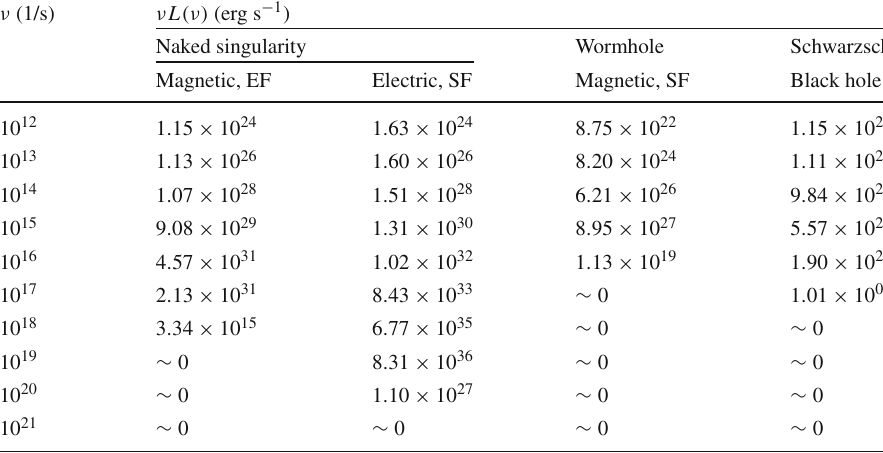
Hz, when it begins to decline to the Schwarzschild profile (not shown). Similar behavior is seen in c . b shows the emission spectra of the disk around WH throat. At low ν , the features are almost indistinguishable from those of BHs but at higher frequency, the spectra diminishes con- siderably. d displays the behavior only for BHs. These features are consistent with efficiency of conversion (see summary)